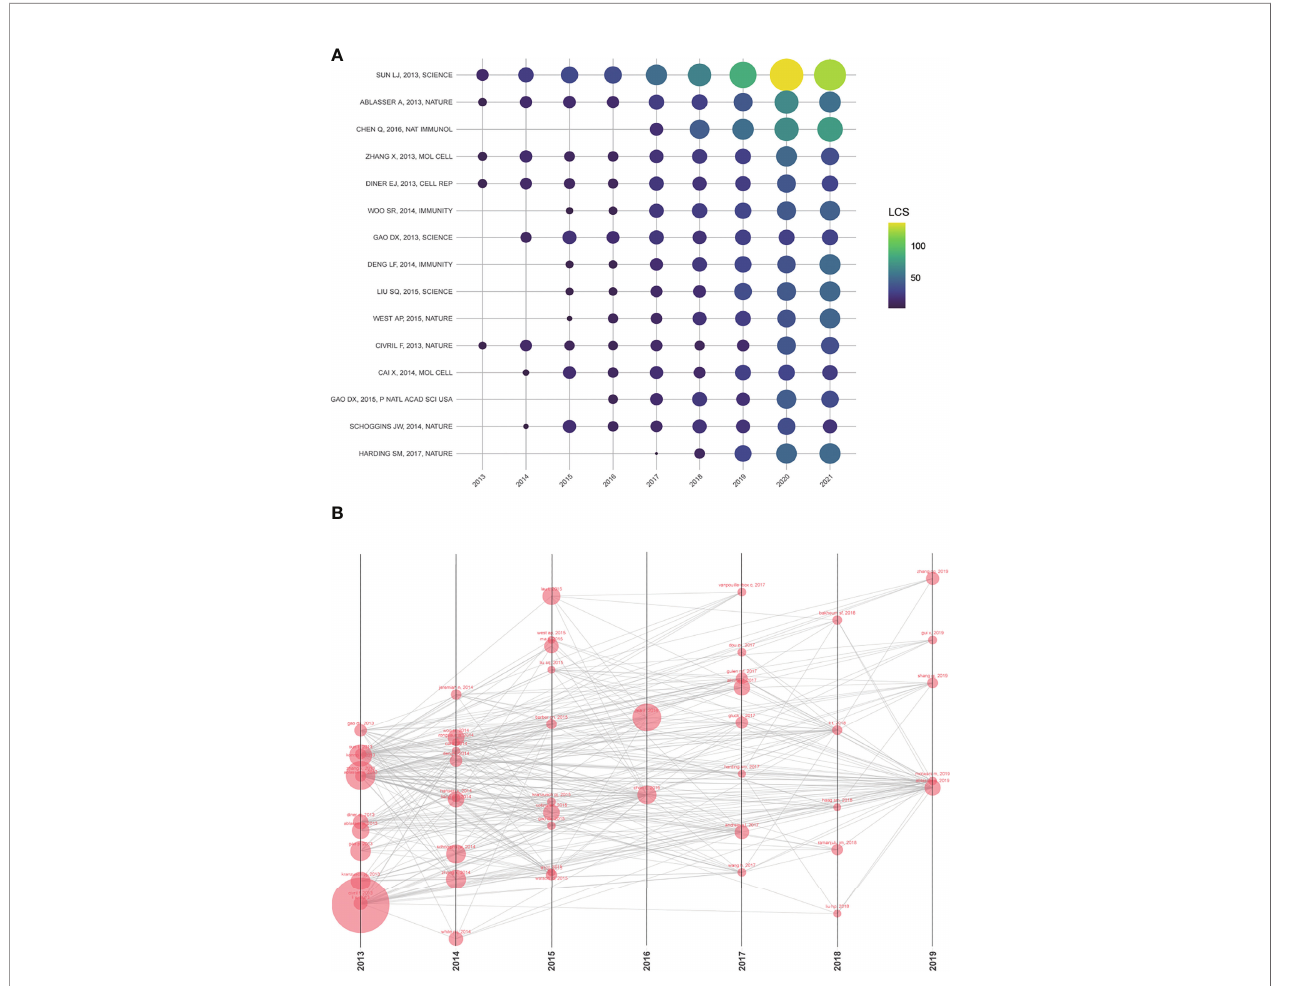
FIGURE 4 | (A) The yearly number of local citations of papers with high local citation scores (LCS). The size and colors of the circle present the LCS of papers in that year. (B) One paper cited by the other papers with the top 50 LCS. The size of each node is proportional to the frequency of this article by the other 49 articles.